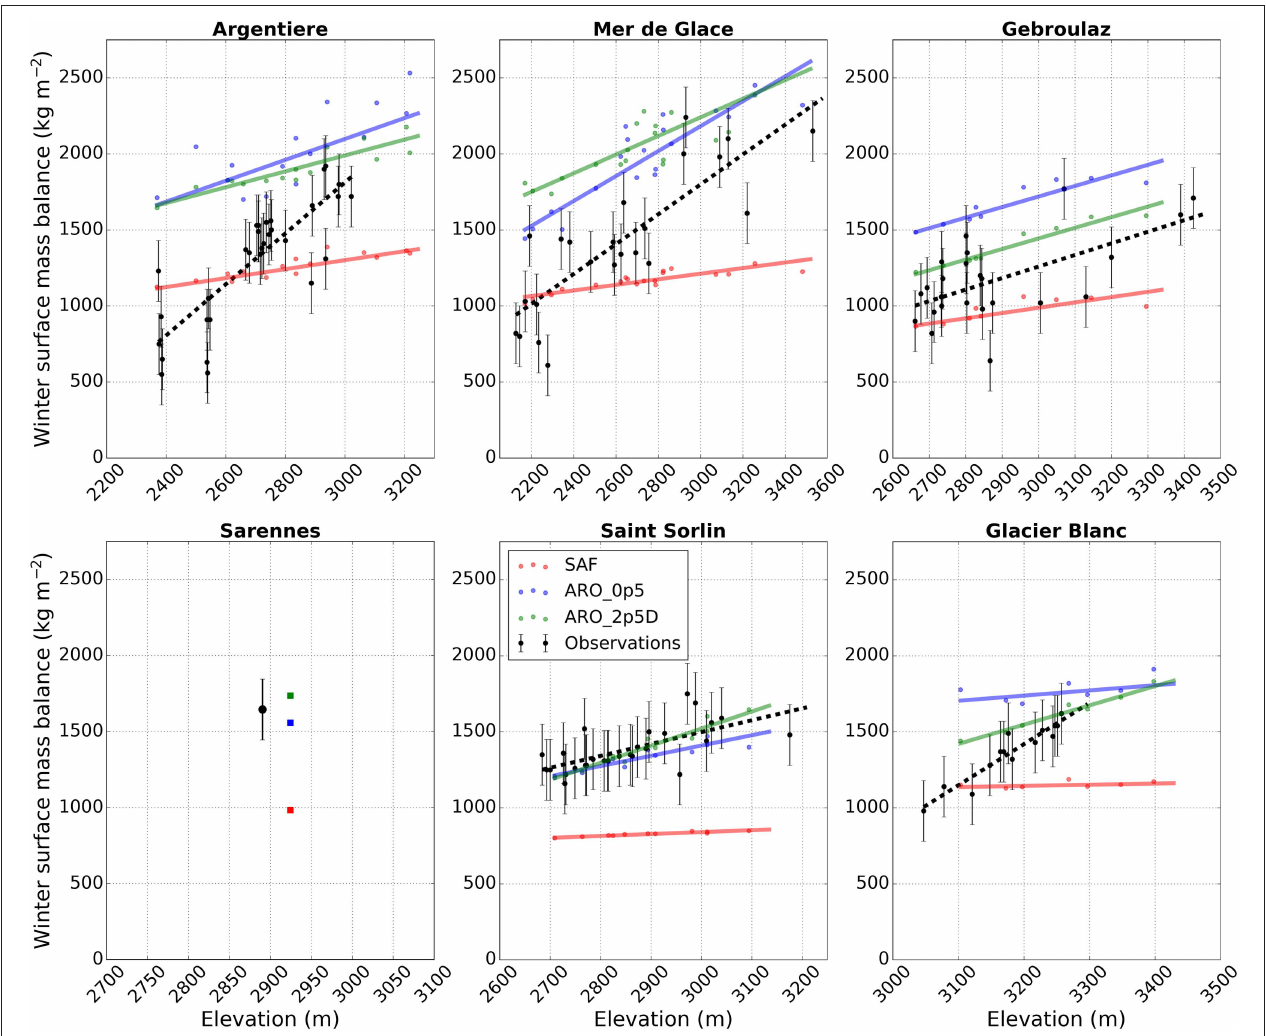
FIGURE 12 | Winter surface mass balance (in kg m − 2 ) for winter 2011–2012 of six glaciers of the French Alps as a function of elevation derived from observations and simulated with Crocus driven by the three forcing datasets. The location of each glacier is given on Figure 1 . For each dataset, the line represents the best-fitted linear regression of winter surface mass balance as a function of elevation. No regression line is shown for Sarennes glacier since it covers a too narrow elevation band. The error bars on the observation points represent the typical measurement error. Note that different elevation ranges are used for each